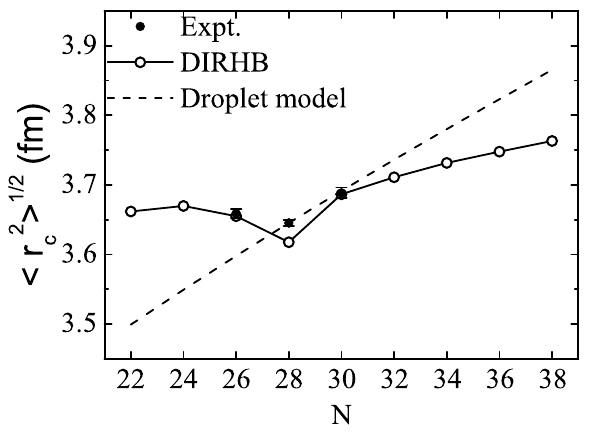
Figure 2. The DIRHB calculated root-mean-square charge radii ( (cid:2) r c 2 (cid:3) 1 / 2 ) for even Cr isotopes. The corresponding data [3] are shown by solid circles. The spherical droplet model estimate (normalized to N = 28 data) for even Cr isotopes are shown by dashed